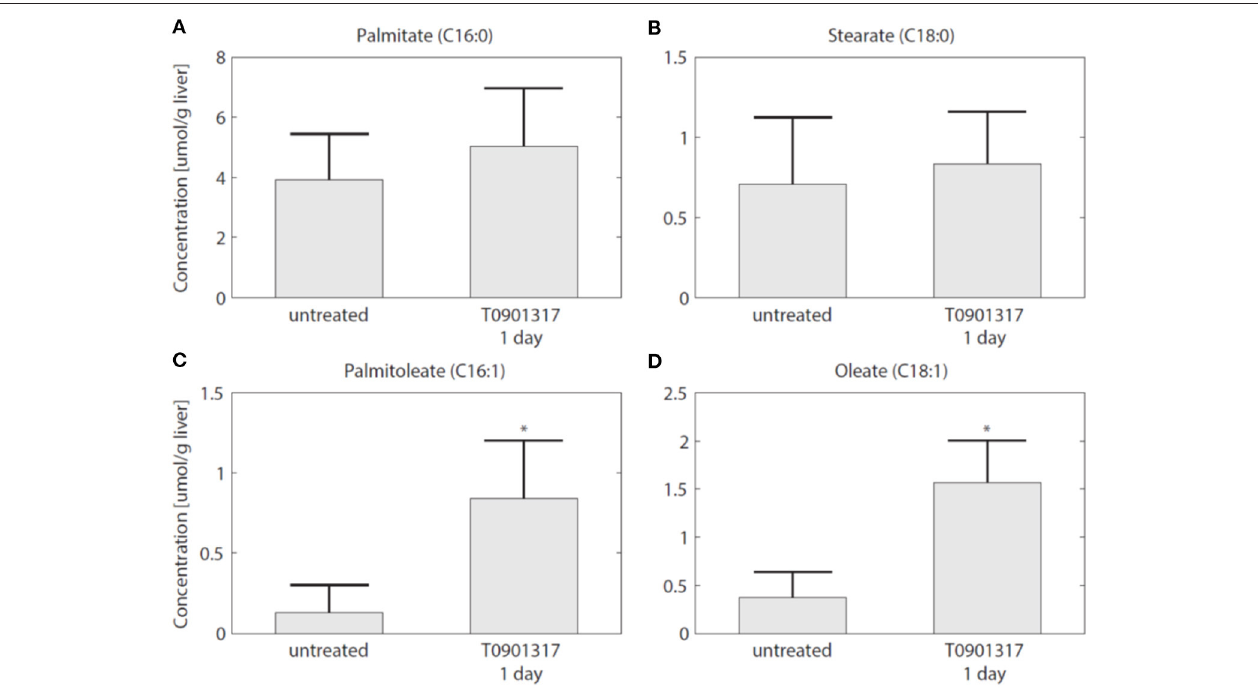
FIGURE 8 | The hepatic uptake of FFA is increased. Additional experiments were performed in which 13 C-palmitate was infused into C57Bl/6J mice that were treated with T0901317 for 1 day, and untreated controls. The different graphs present the contribution of plasma palmitate to hepatic palmitate (A) , stearate (B) , palmitoleate (C) , and oleate (D) . The contribution of plasma palmitate to hepatic palmitoleate and oleate was increased after 1 day of LXR activation, thereby confirming the model estimation presented in Figure 7 . The bars represent mean + standard deviation, * p < 0.05, Mann–Whitney U